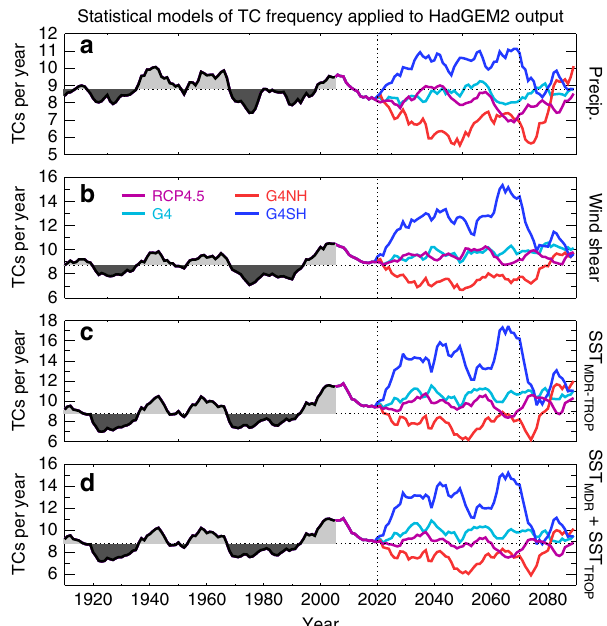
Statistical models of TC frequency applied to HadGEM2 output